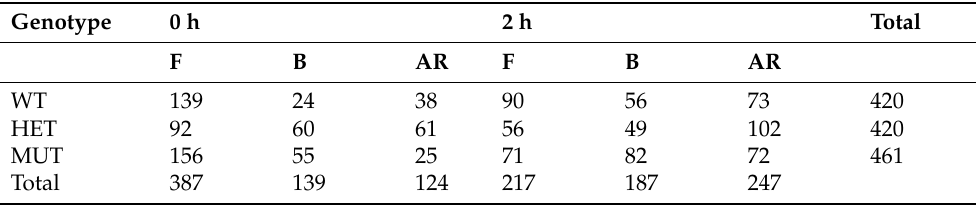
Figure 3. Chlortetracycline (CTC) fluorescence staining patterns of spermatozoa capacitation. ( a ) Uncapacitated, acrosome-intact sperm, with uniform fluorescence throughout the head (corresponds to group F in Table 4). ( b ) Capacitated, acrosome-intact sperm, with uniform fluorescence at the anterior head (corresponds to group B in Table 4). ( c ) Capacitated, acrosome-reacted spermatozoa, with a thin band only in the equatorial segment and faint fluorescence in the whole head (corresponds to group AR in Table 4). All capacitation states exhibit bright fluorescence in the midpiece. Bar = 5 µm. Table 4. Sperm count for capacitation pattern characterization.